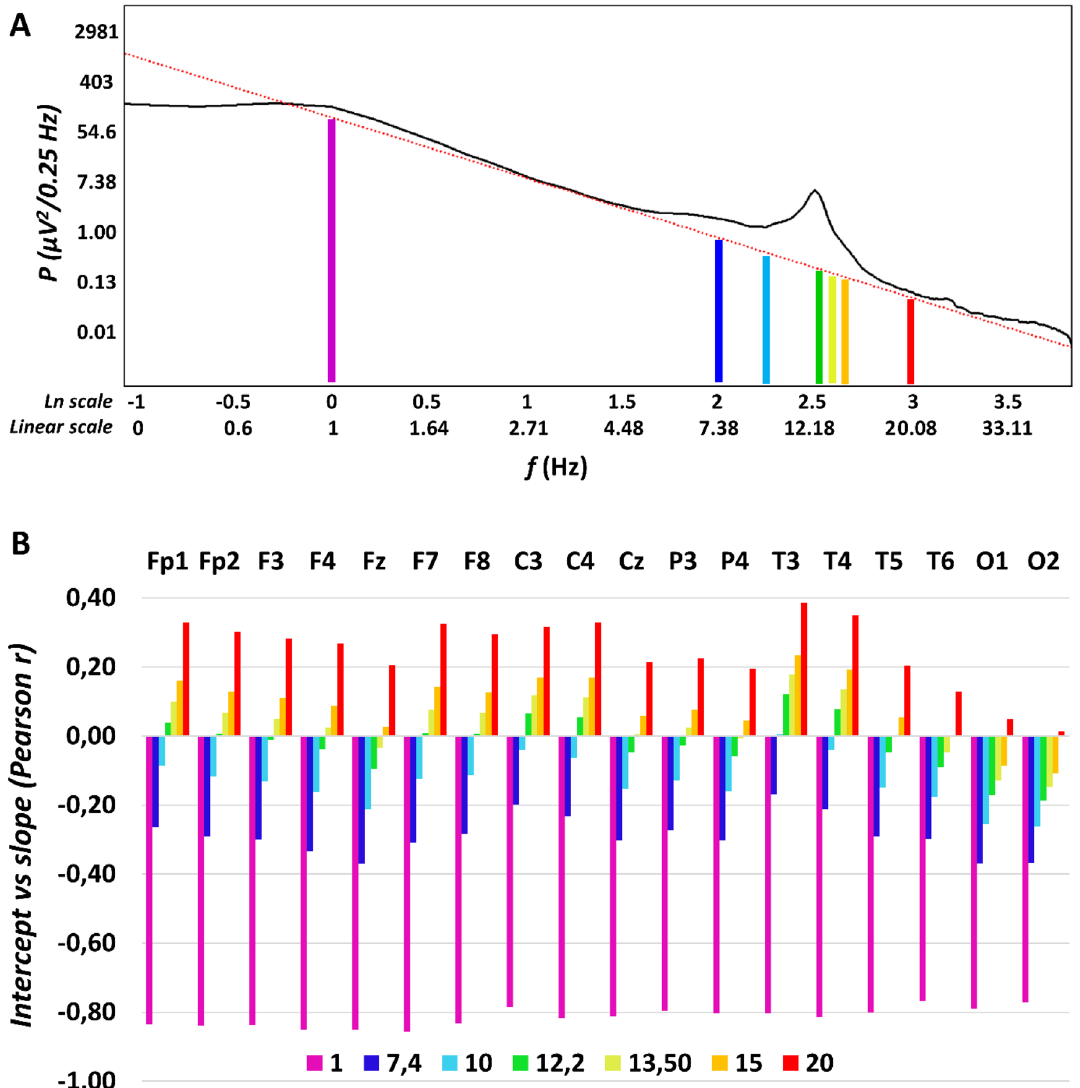
Figure 6. Determining the optimal alternative intercept for the NREM sleep EEG spectra. ( A ) Linear fitted to the double logarithmic plot of an average NREM sleep EEG spectral power ( P ) derived from right frontopolar location (Fp2) in a young female volunteer. Beside the original, violet-coloured intercept at ln f = 0 ( f = 1 Hz), alternative intercepts are depicted at 7.4, 10, 12.2, 13.5, 15 and 20 Hz. ( B ) Between-subject correlations of the potential intercepts (ln C ) with the slopes of the spectra (α) in a location-dependent manner. Note the negative correlations for low and the positive correlation for high frequencies, respectively. Zero-correlations are seen in the middle of the sleep spindle frequency range (at 12.2 and 13.5 Hz), although occipital recording locations are characterized by a slightly different